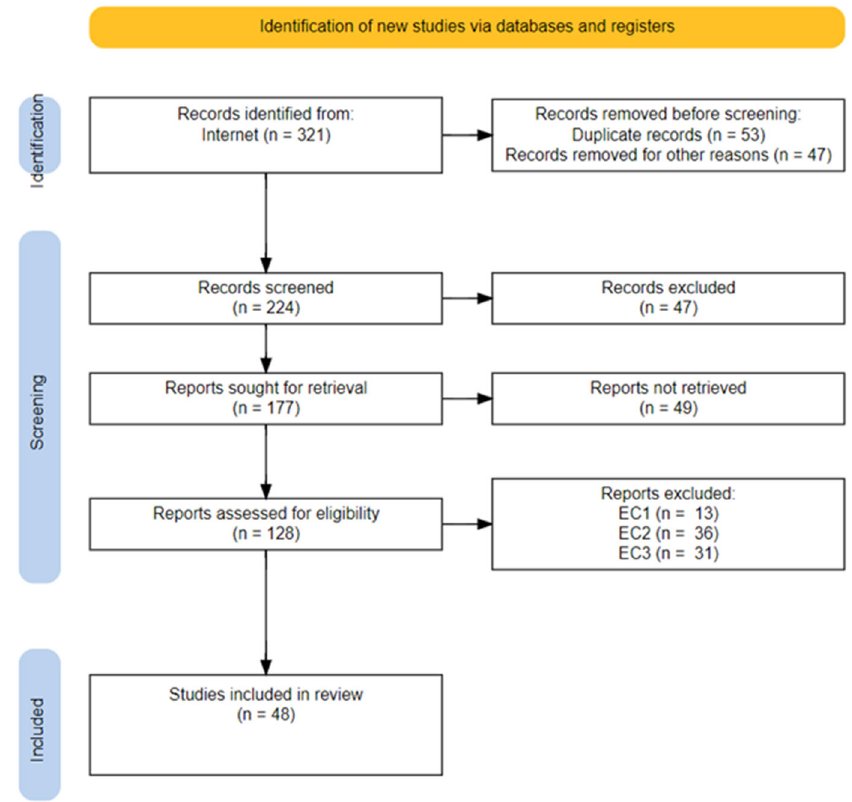
Figure 5. PRISMA flowchart of first primary question.